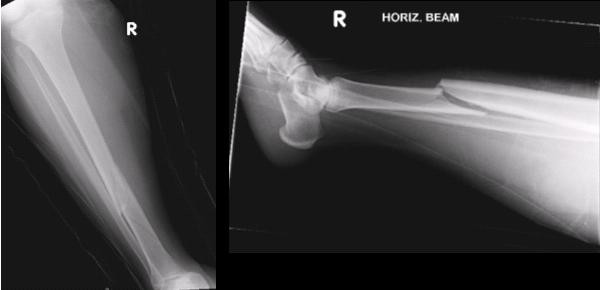
Initial radiographs.